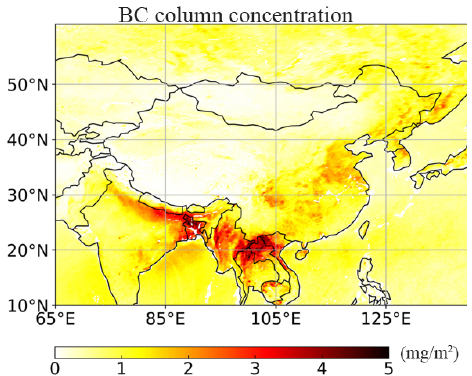
Figure 4. Climatological BC column mass concentration (mgm − 2 ) derived from POLDER-3 observations using the GRASP/Compo- nent approach for the period from March 2005 to October 2013 in